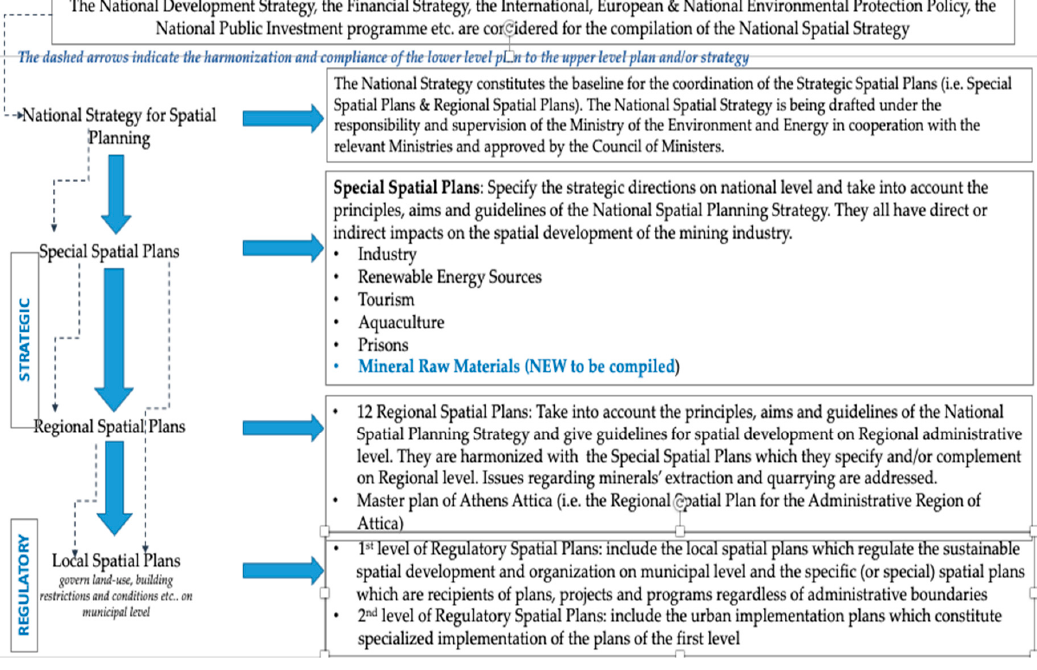
Figure 4. The structure of the Greek Spatial Planning System according to Law 4447/2016 “Spatial planning-sustainable development and other provisions”, Source: [41] and authors’ own elaboration.